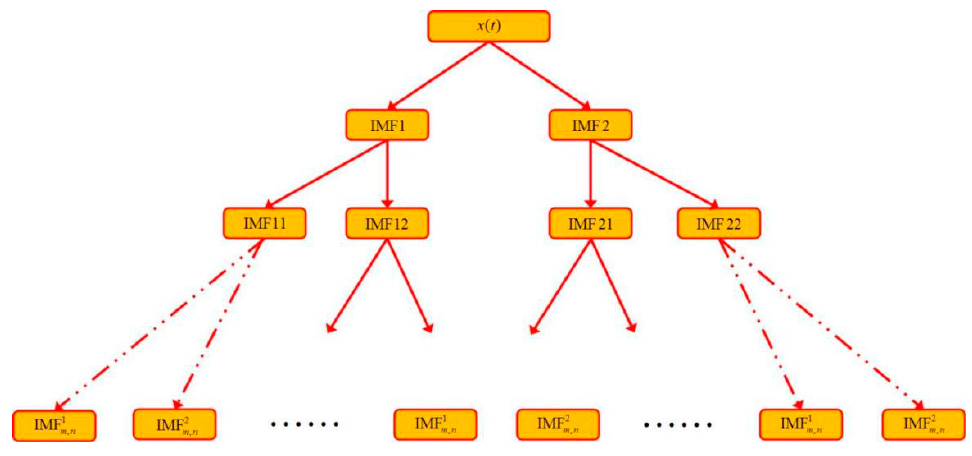
Figure 2. Diagram of binary tree decomposition.